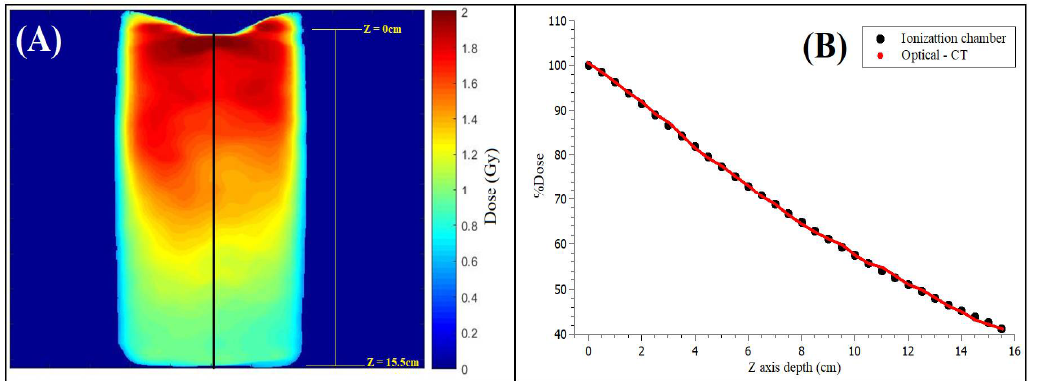
Figure 1. ( A ) Calibration curve achieved (black line) for calibration purposes from irradiation with 2 Gy delivered to the maximum dose depth. All the attenuation values outside the calibration range (0.8–2.0 Gy) were set to 0 Gy (dark blue). The black line represents the central axis used to build the PDD curve, using the inside gel values starting at a maximum 2 Gy dose value. ( B ) Measured PDD at the central axis of the gel phantom and the expected PDD value from the LINAC’s dosimetric table data.